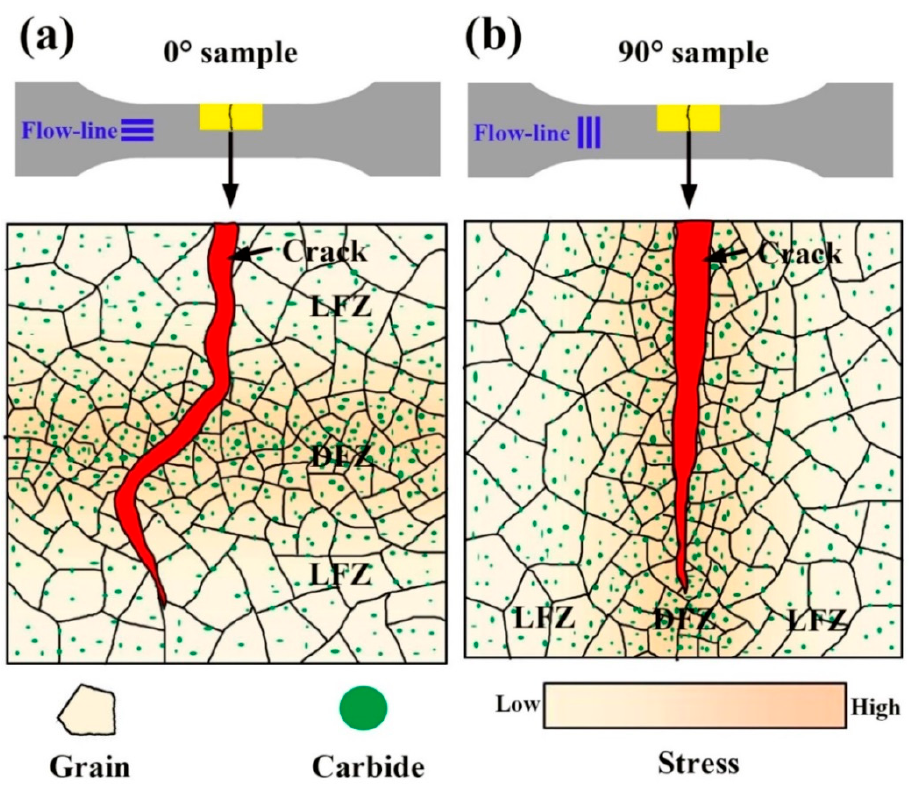
Figure 14. Schematic illustrations showing the effect of the flow lines on the mechanical anisotropy: ( a ) 0° sample; ( b ) 90° sample.